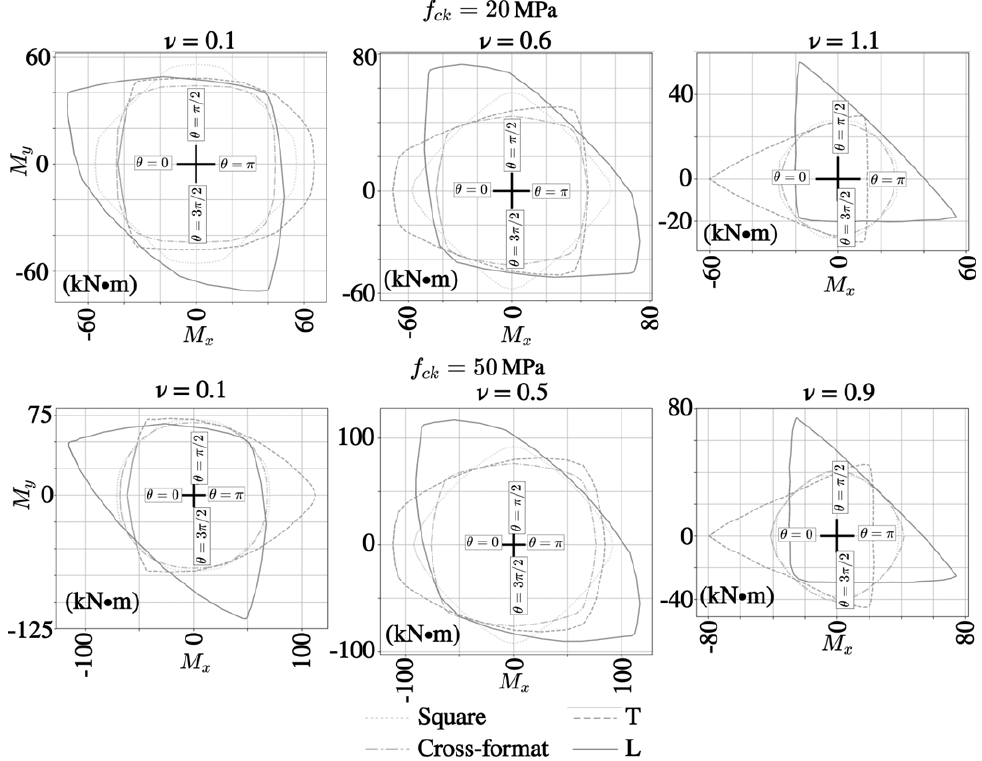
Figure 8. Influence of section shape on sections with